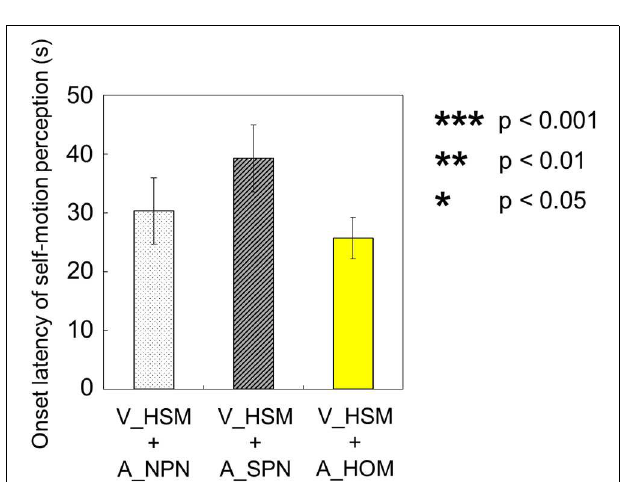
FIGURE 5 | Averaged values of the (A) strength and (B) duration of self-motion perception in the condition combining visually horizontal shearing motion (V_HSM) and auditorily stationary